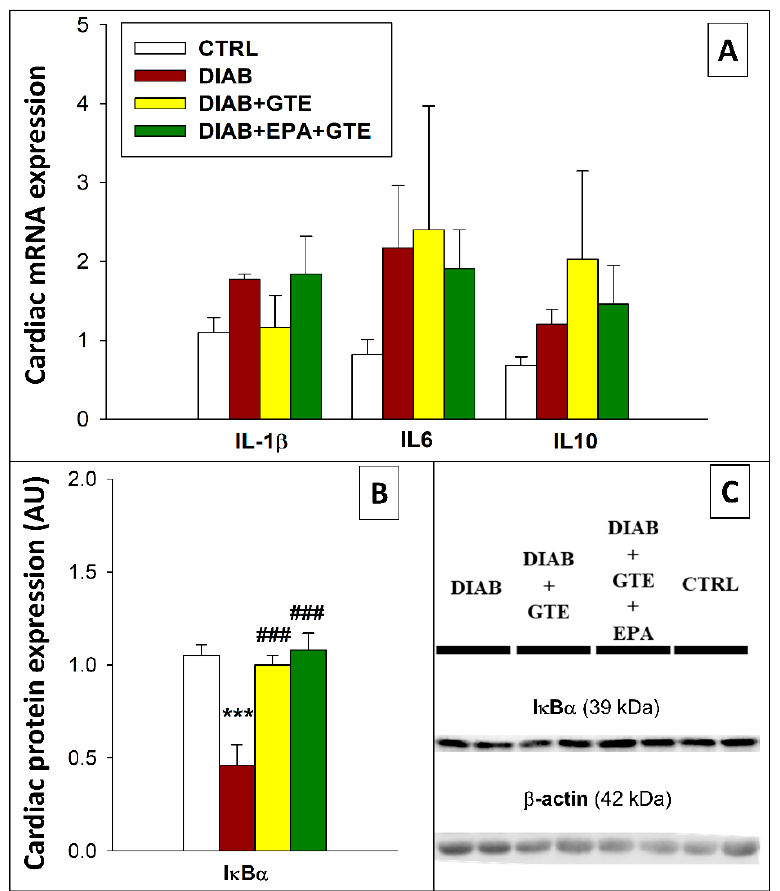
Figure 6. Inflammation parameters. ( A ) Inflammation-related mRNA expression; ( B ) Inflammation-related protein expression; and ( C ) Representative immunoblots. CTRL: Control group; DIAB: Diabetic rats; GTE: Green tea extract enrichment; and EPA: Eicosapentaenoic acid enrichment. *: Different to the CTRL group; #: Different to the DIAB group. One symbol: p < 0.05; two symbols: p < 0.01; and three symbols: p < 0.001.